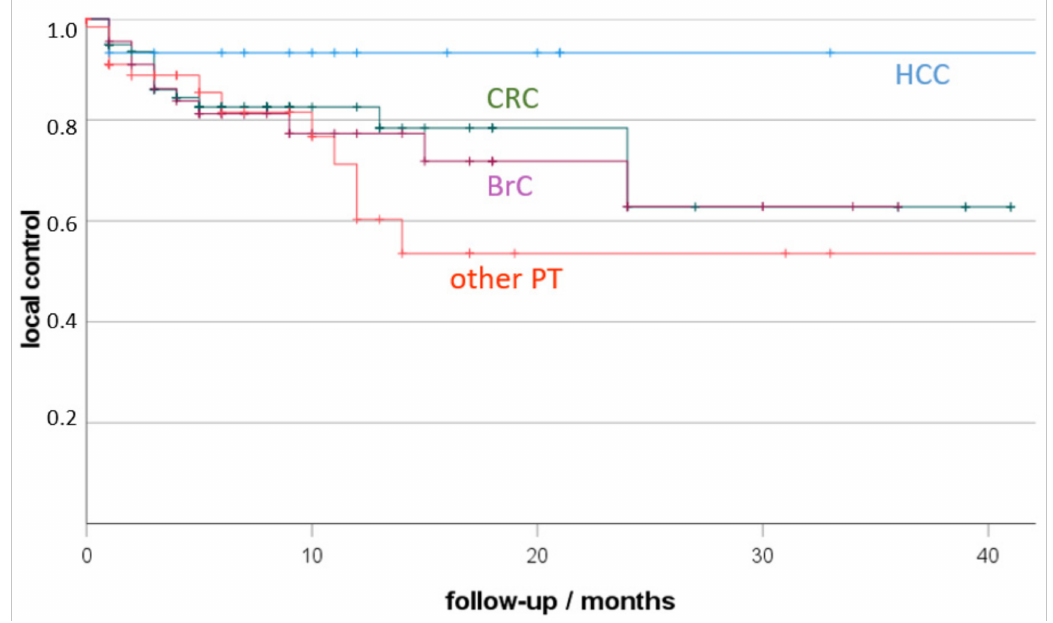
Figure 2. Local tumour control (LTC) depending on primary cancer (HCC, hepatocellular cancer, CRC, colorectal cancer; BrC: breast cancer; other PT: other primary tumour; +, censored). Non-parametric Kaplan-Meier estimate of post-therapeutic LTC sorted by malignancy.